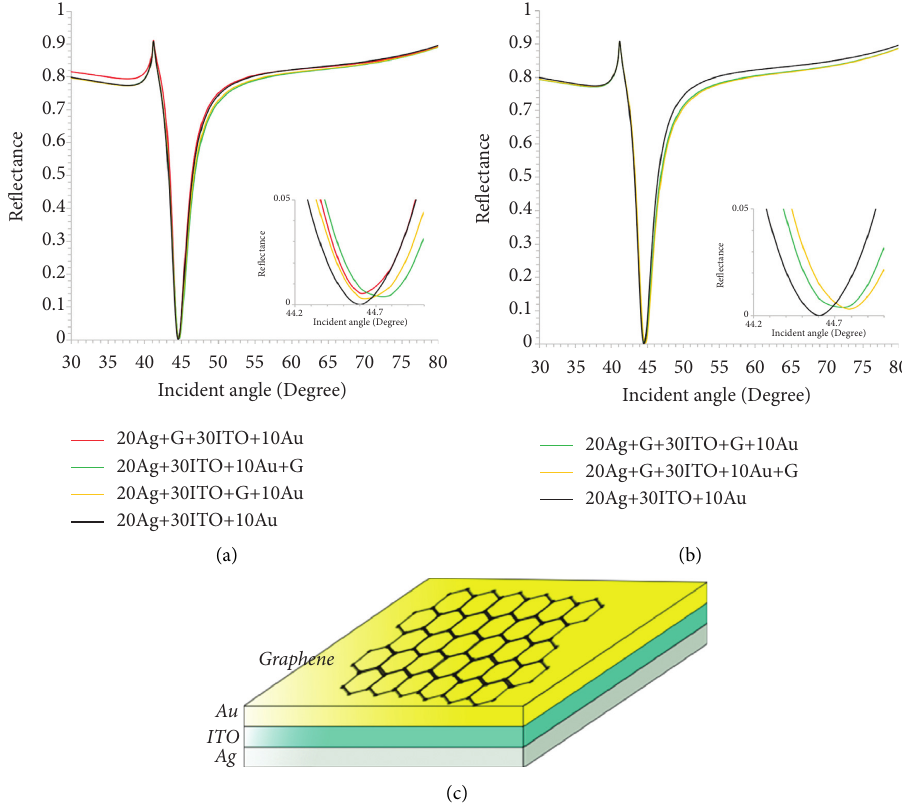
Figure 5: Sensor reflectivity after graphene was added. (a) A graphene monolayer was added at different positions in the sensor; (b) double- layer graphene was added at different positions in the sensor (unit: